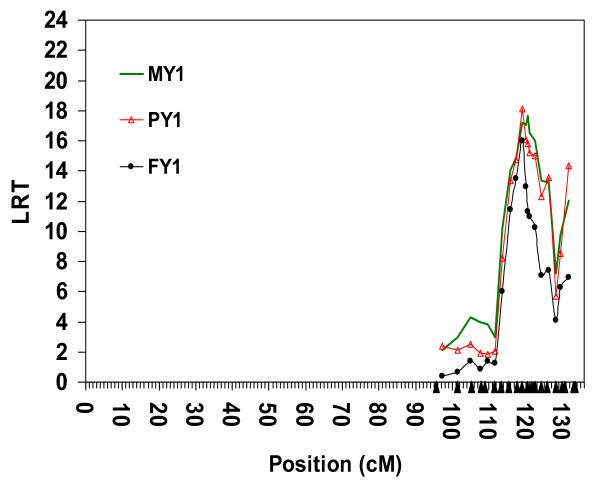
LDL analysis by variance component approach using microsatellites in a complex pedigree of 1 038 animals. Joint linkage disequilibrium and linkage (LDL) analysis for three milk yield traits; Milk Yield (MY1), Milk Protein Yield (PY1) and Milk Fat Yield (FY1) during first lactation using 21 microsatellites covered the most likely region containing the QTL in the distal part of bovine chromosome 5 (BTA5), a complex pedigree of 1 038 animals, EBV as phenotype and AIREML as implemented in LDLRAMS and LDL program. Chromosome length in centiMorgan (cM) on the X-axis, log-likelihood ratio test (LRT) values on the Y-axis. Solid triangles on the X-axis represent positions of markers included in the analysis.